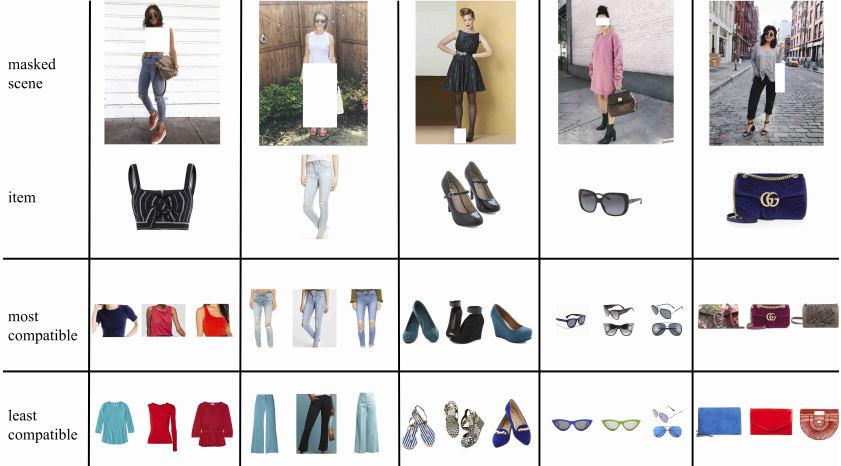
Figure 13. Visualizations of the top 3 most and least compatible items predicted by BOCTP on different categories of items.